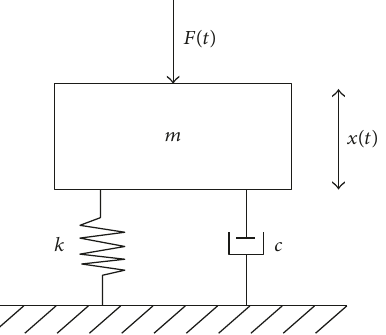
Figure 1: Antivibration system with single degree of freedom.